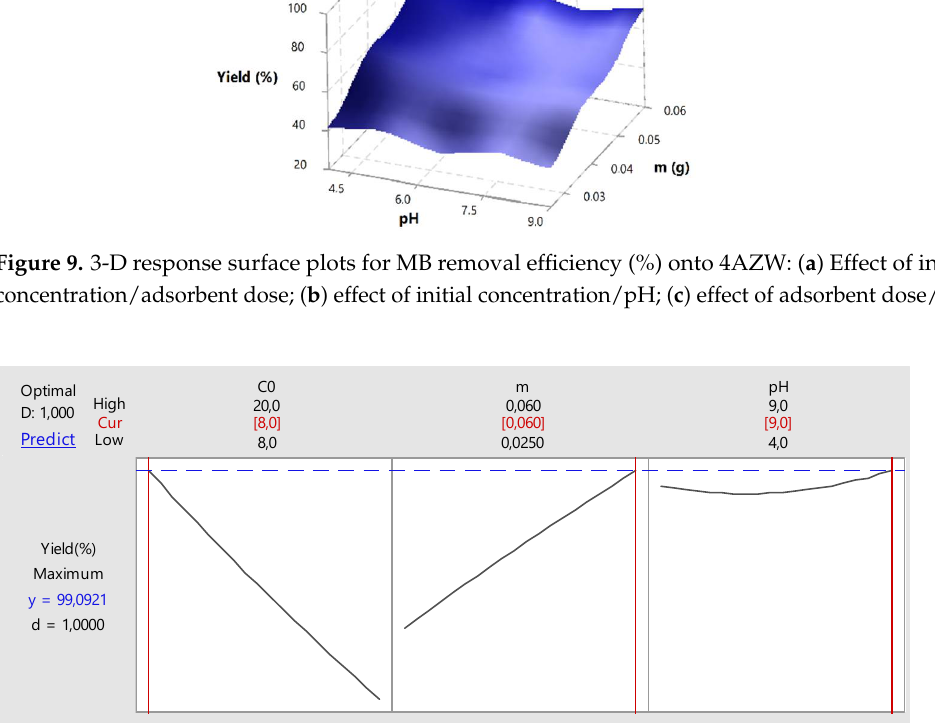
Figure 9. 3-D response surface plots for MB removal efficiency (%) onto 4AZW: ( a ) Effect of initial concentration/adsorbent dose; ( b ) effect of initial concentration/pH; ( c ) effect of adsorbent dose/pH.